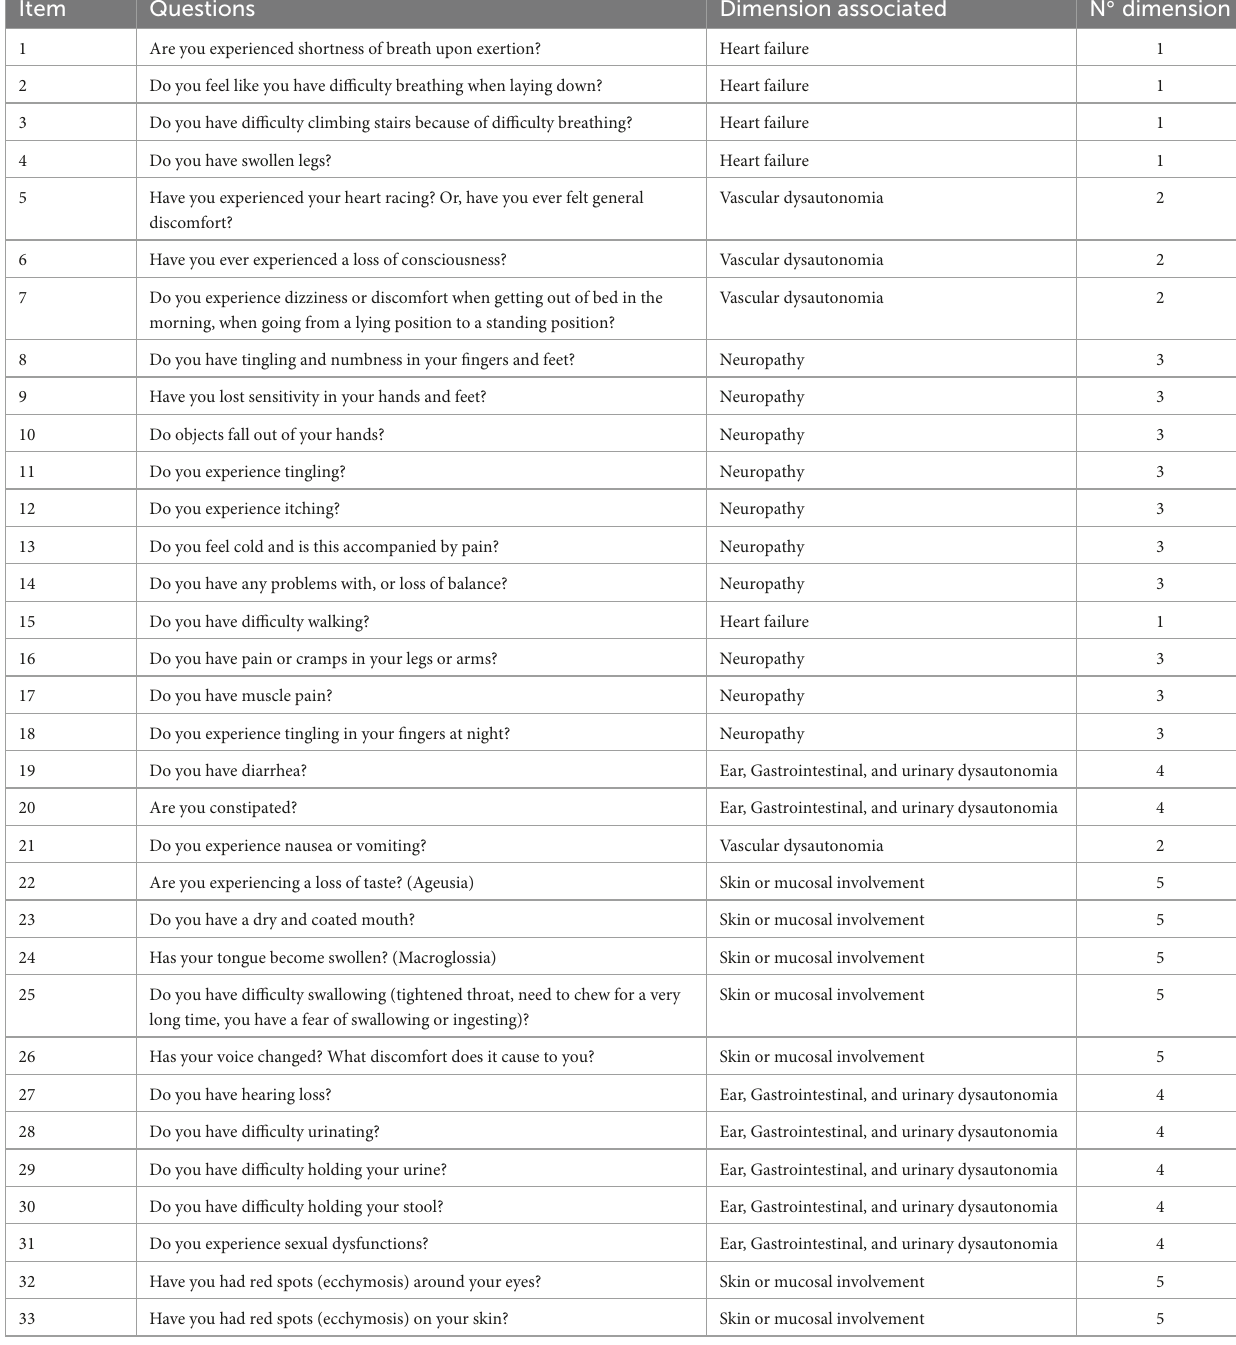
TABLE 3 Description of Amylo-AFFECT’s items scored with a 4-point Lickert scale. Item